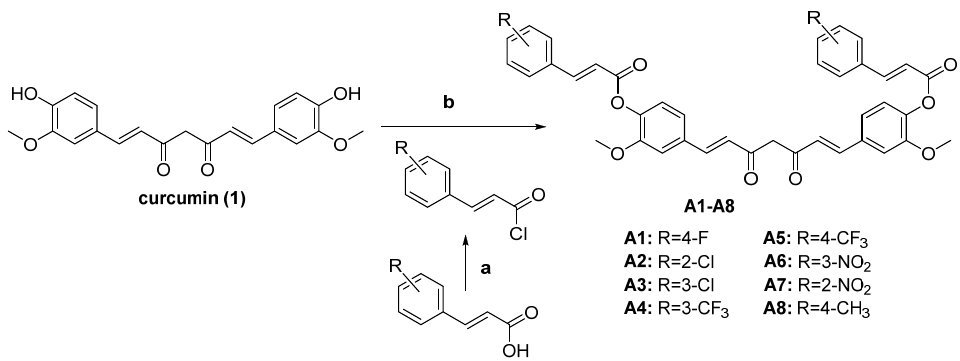
Scheme 1. Synthesis of the curcumin analogs A1–A8 . Reagents and conditions: ( a ) SOCl 2 , 80 °C, reflux, 2 h; ( b ) CHCl 3 , triethylamine, 0 °C to room temperature, 12 h.